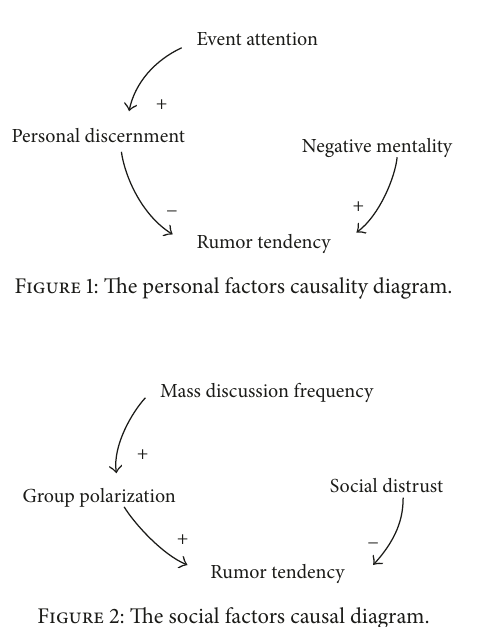
Figure 2: The social factors causal diagram.